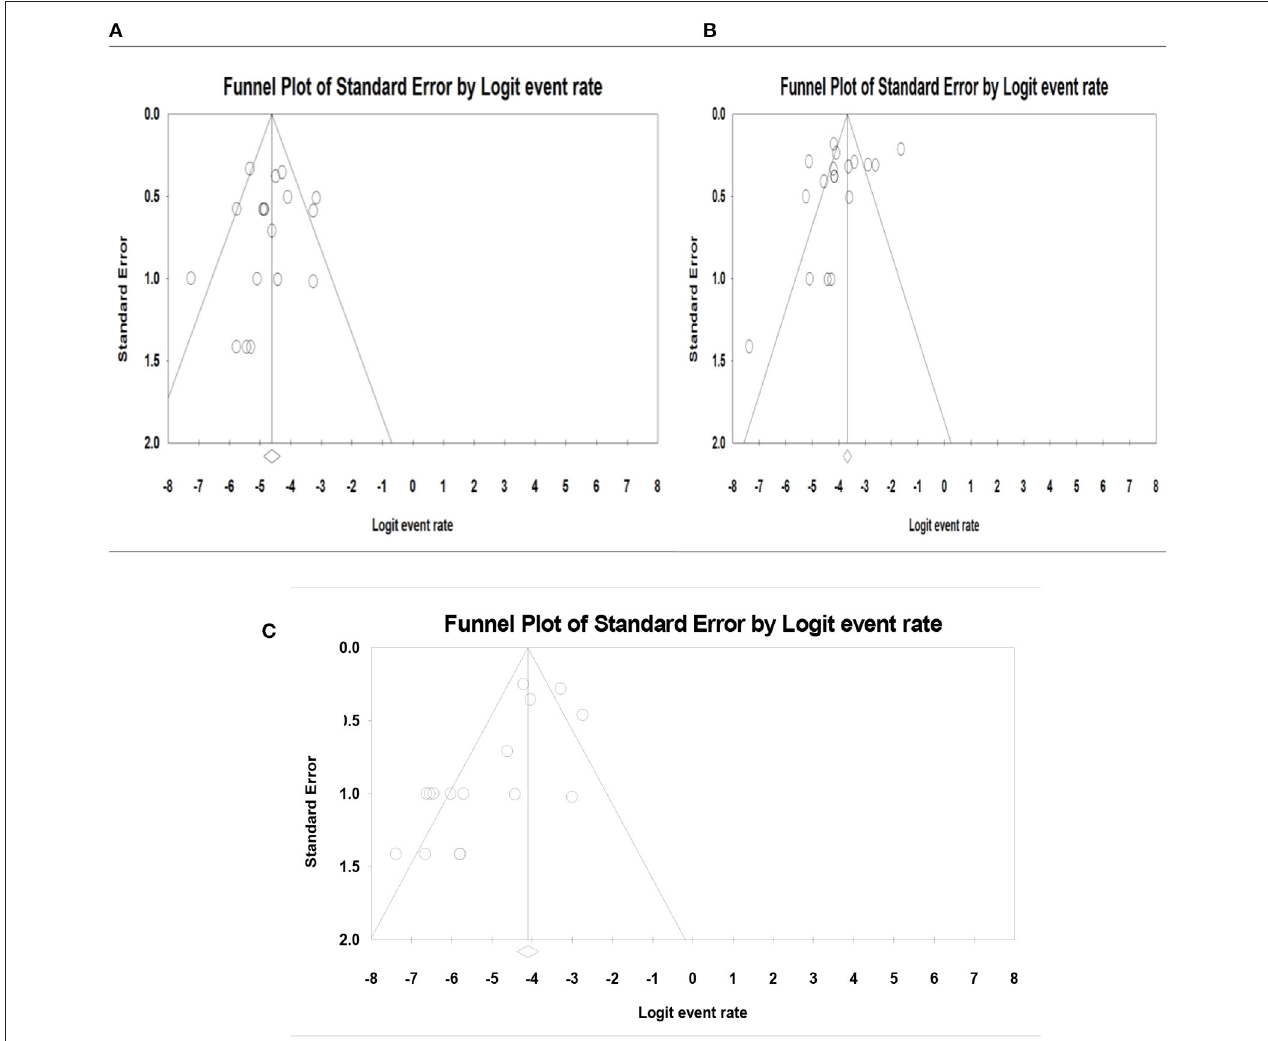
FIGURE 8 | Funnel plot for publication bias assessment in BuV (A) , SAFV (B) , and CosV (C)